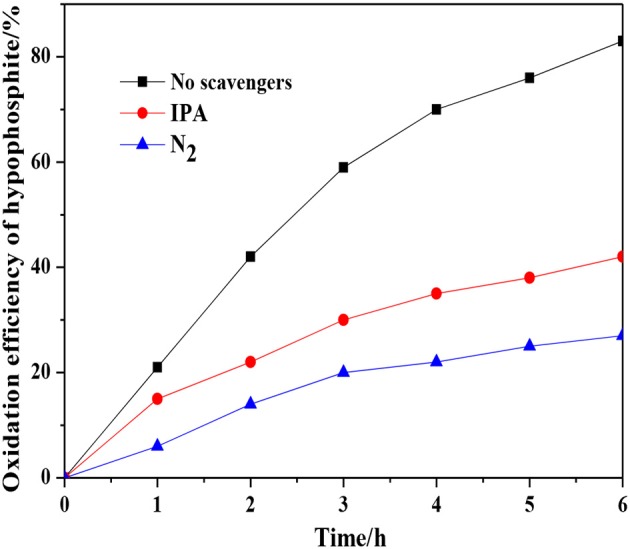
Effect of radical scavengers on the photocatalytic oxidation of hypophosphite by the 1:2-Ti4O7/g-C3N4 photocatalyst.